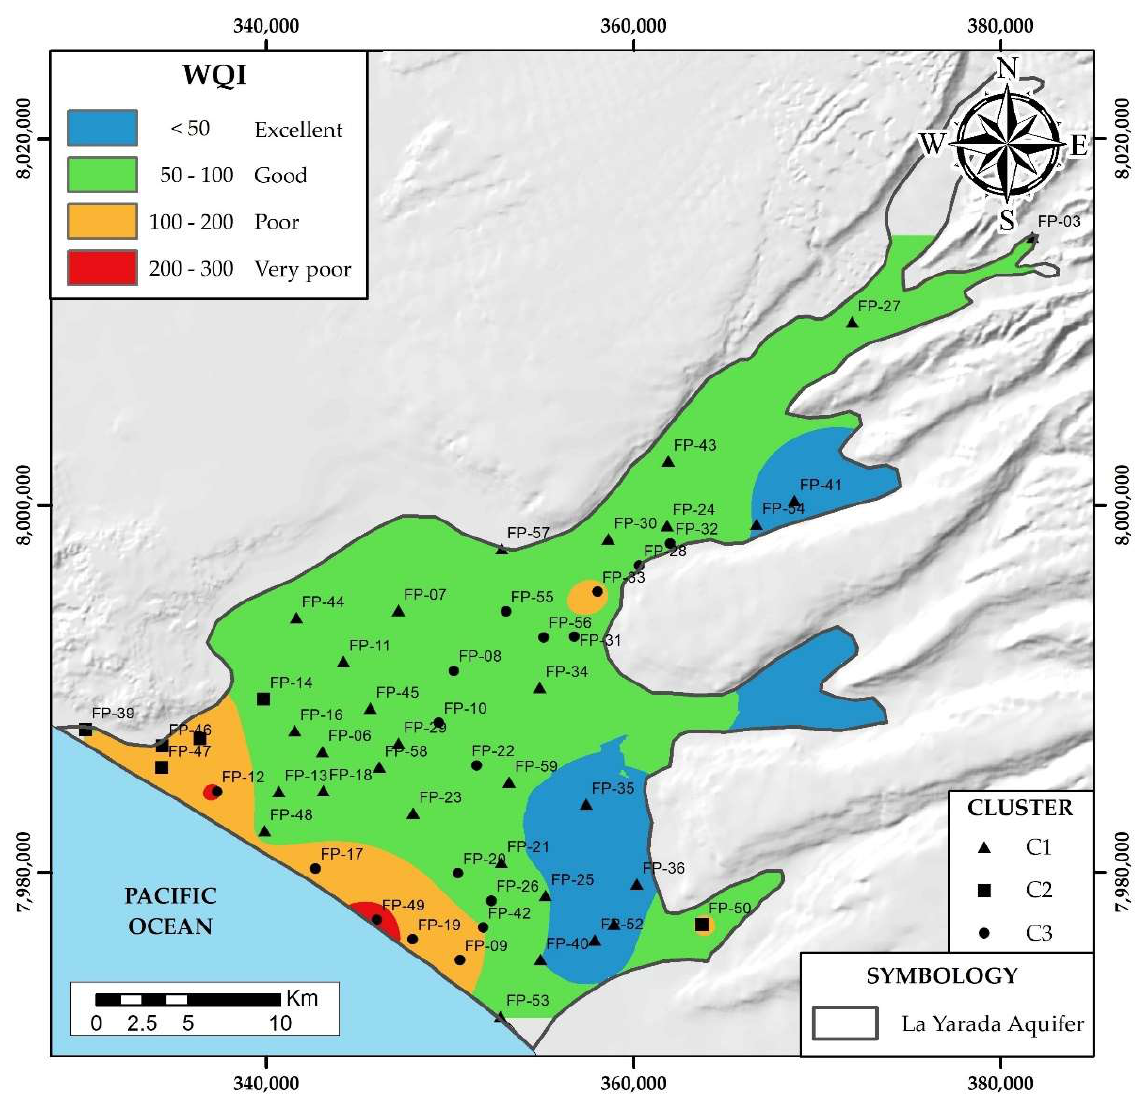
Figure 13. Spatial distribution of the quality of water for human consumption.